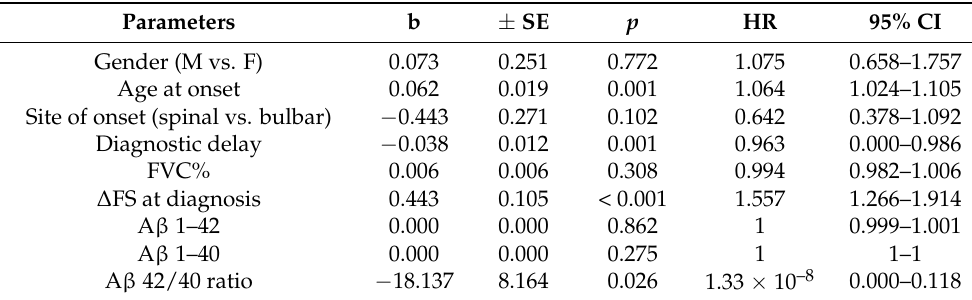
Table 5. Univariate Cox regression analysis for the overall survival for ALS patients. Parameters